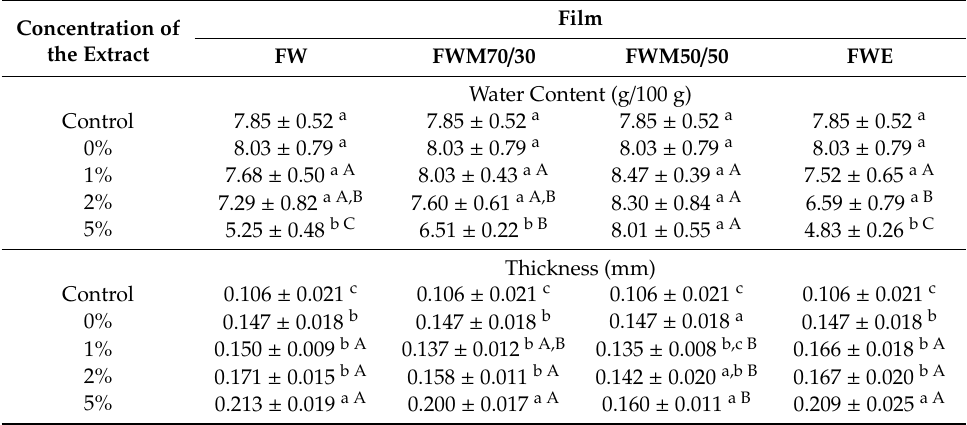
Table 6. Water content and thickness of starch films with chicory root extracts and phytic